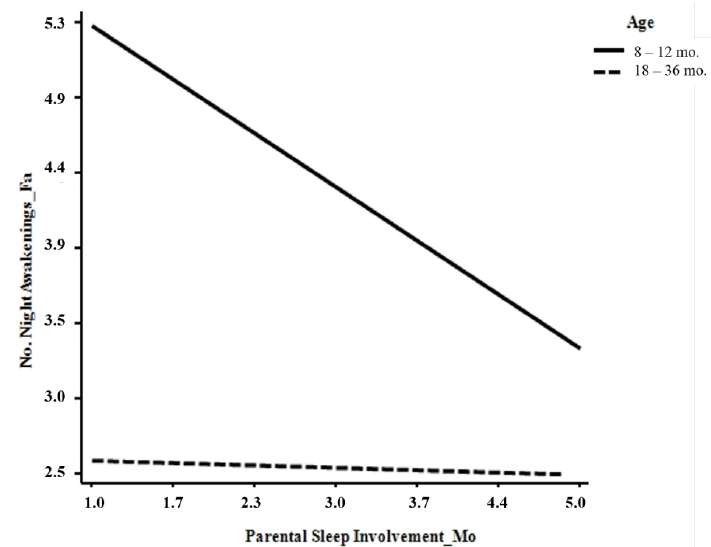
Figure 3. Links between paternal sleep involvement and the number of night awakenings reported by fathers.